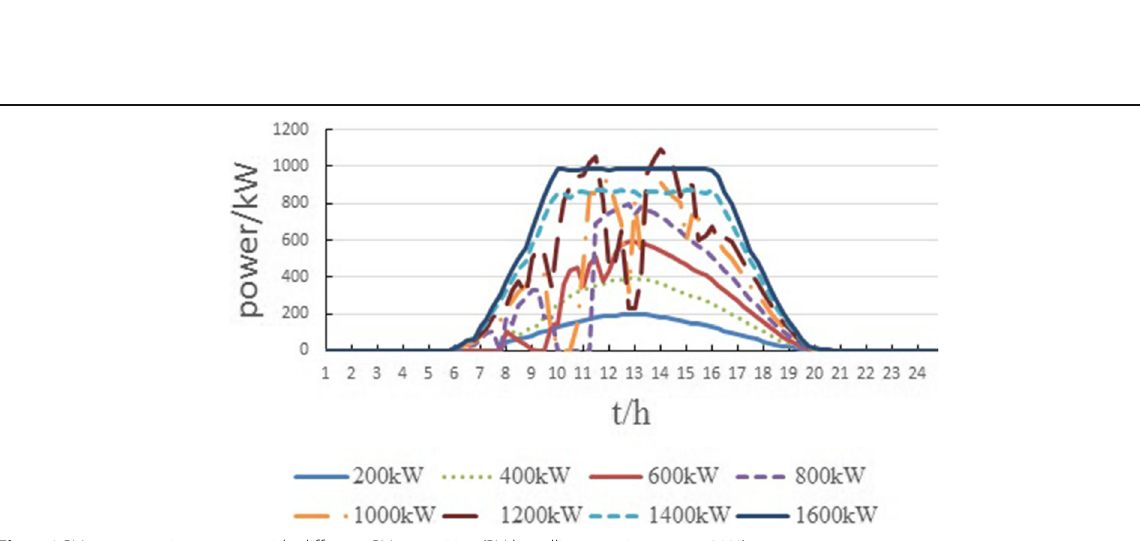
Fig. 16 PV consumption curves with different PV capacities (PV bundling requirement =